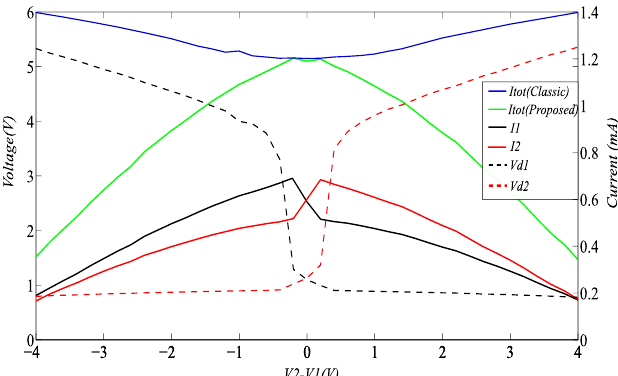
Figure 21. Measurement results for the proposed bump circuit with input differential pair. The differ- ential input signals V 1 and V 2 are varied in a range [4 V–8 V] with a step of |0.1 V| and characterized by an input common-mode of 6 V. V Bias = 7 V.